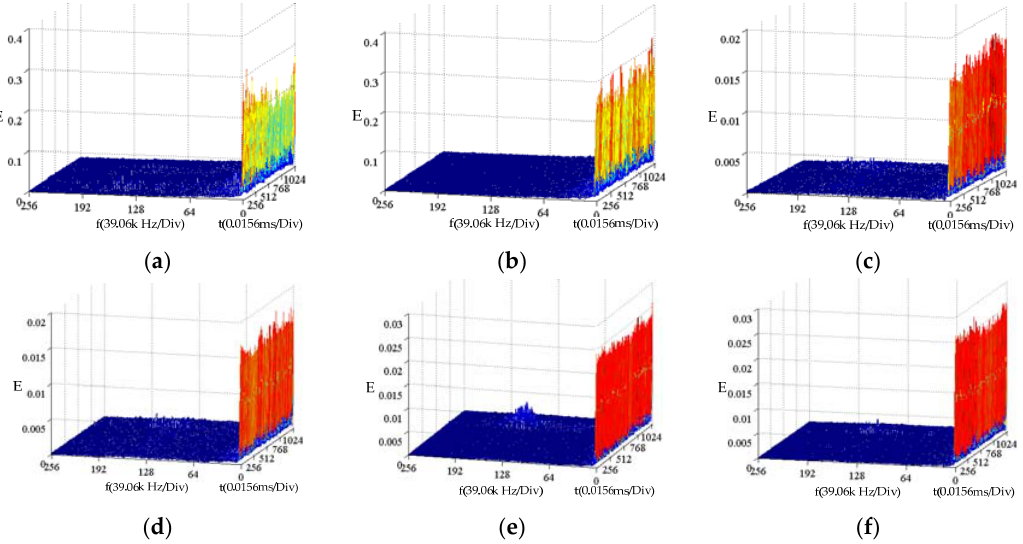
Figure 12. Time–frequency–energy 3D spectrums by IHHT for ( a ) Type I ( b ) Type II ( c ) Type III ( d ) Type IV ( e ) Type V and ( f ) Type VI.